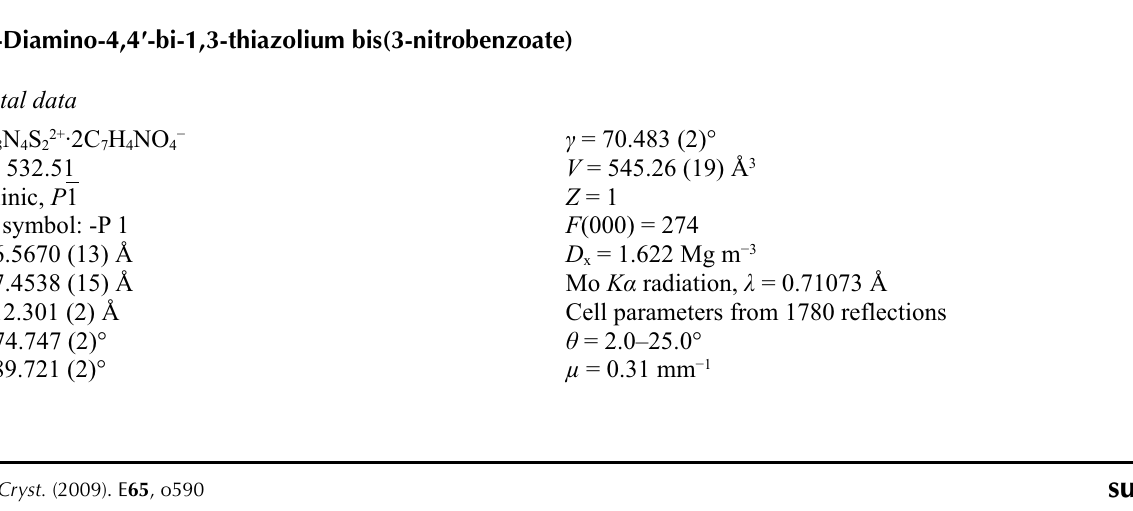
The unit cell packing diagram showing hydrogen bondings between thiazole rings and carboxyl groups of 3-nitrobenzoate